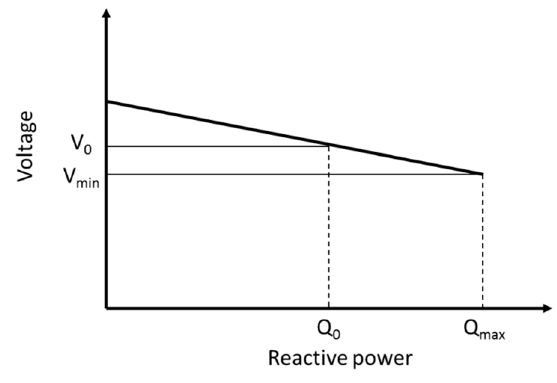
Figure 7. V ‐ Q droop characteristic in the AC microgrid.